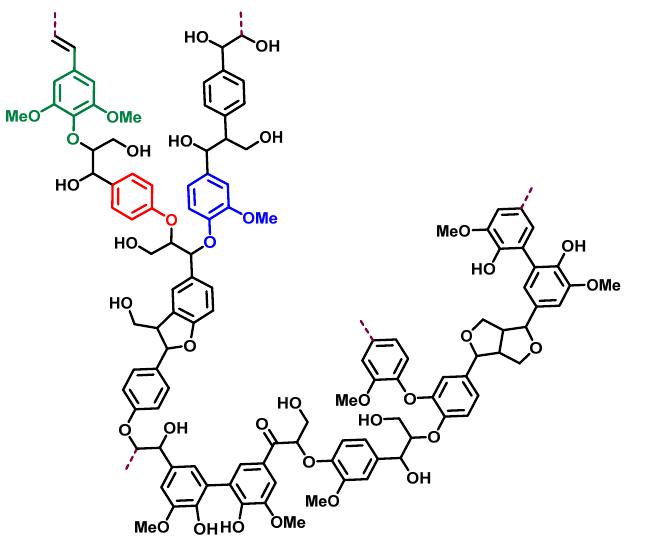
Figure 19. Lignin structure with guaiac-based moiety (blue), syringyl moiety (green) and p-hydroxyphenyl moiety (red).